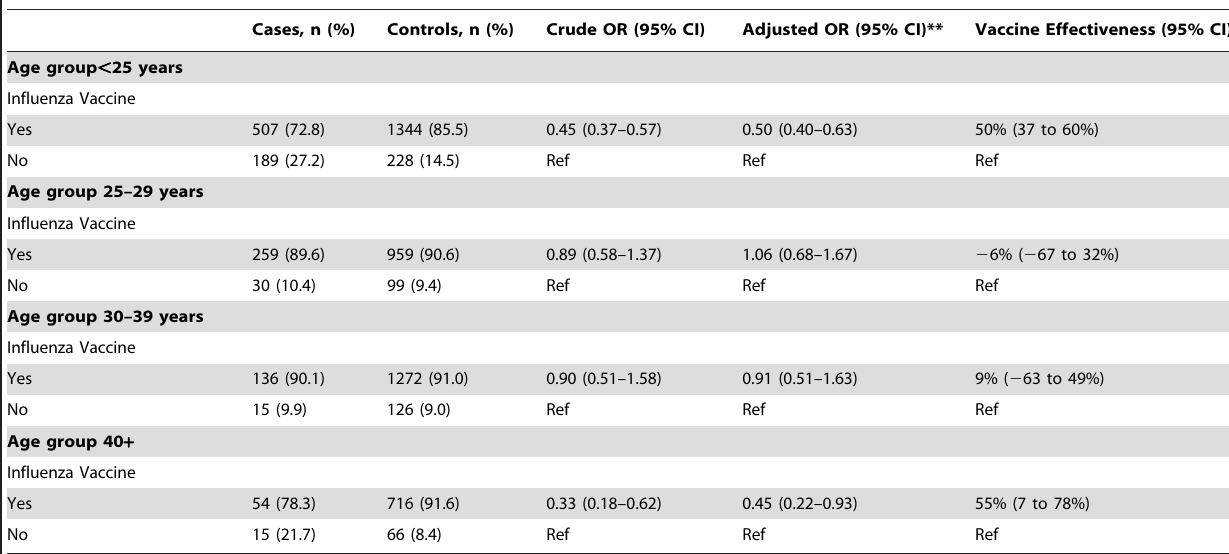
Table 3. Crude and Adjusted OR for Specific Age-Groups for Any Vaccine Received in 2008–2009.